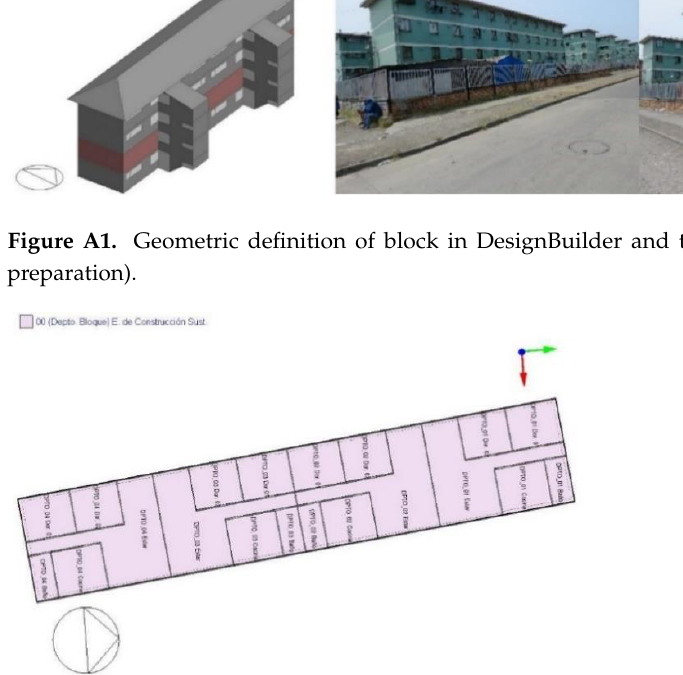
Figure A2. Floorplan Blocks (authors’ own preparation).